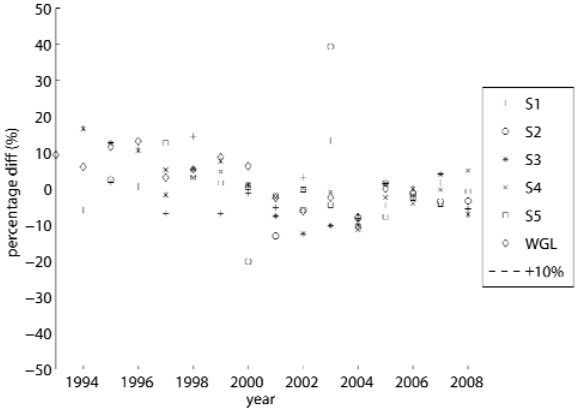
Figure 6. Annual mean wind speed of 5 GTS stations and HKO station (Waglan Island) from 1993 to 2008, see Figure 2 for exact locations.